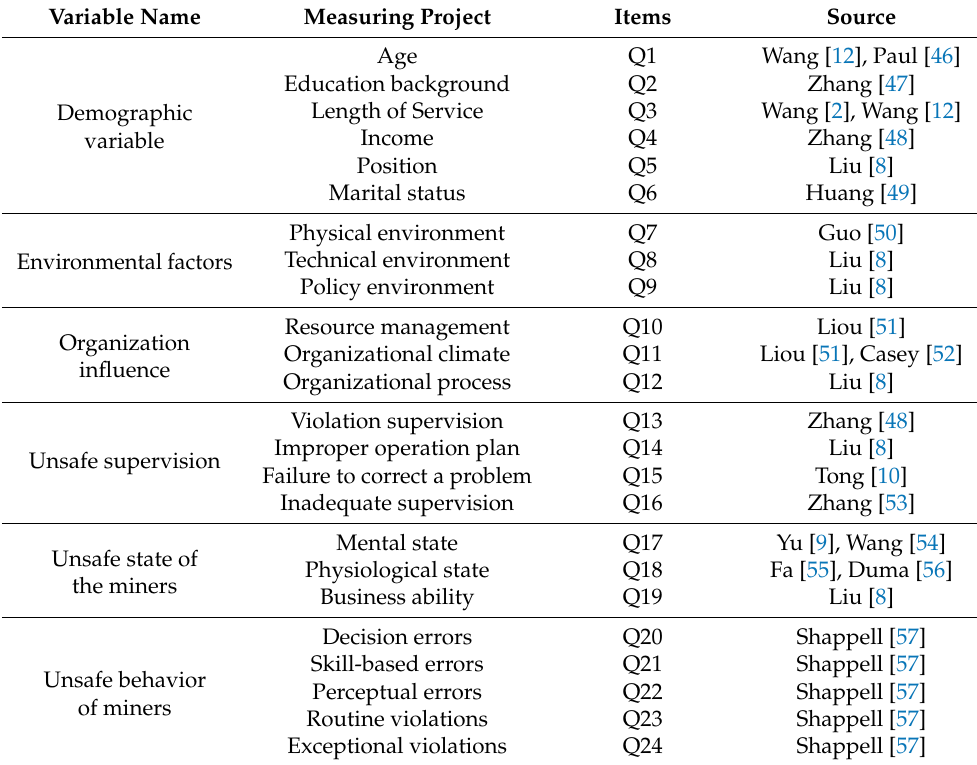
Table 2. Survey Scale of Unsafe Behavior and Risk Factors of Miners in the Deep Coal Mine.